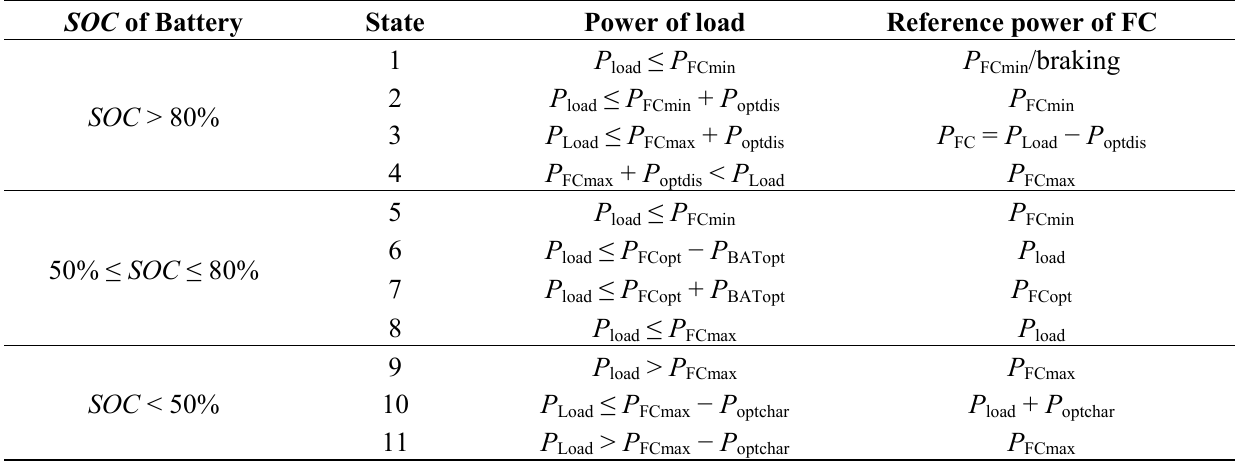
Table 4. Summay of the operating states. SOC : state of charge. SOC of Battery State Power of load Reference power of